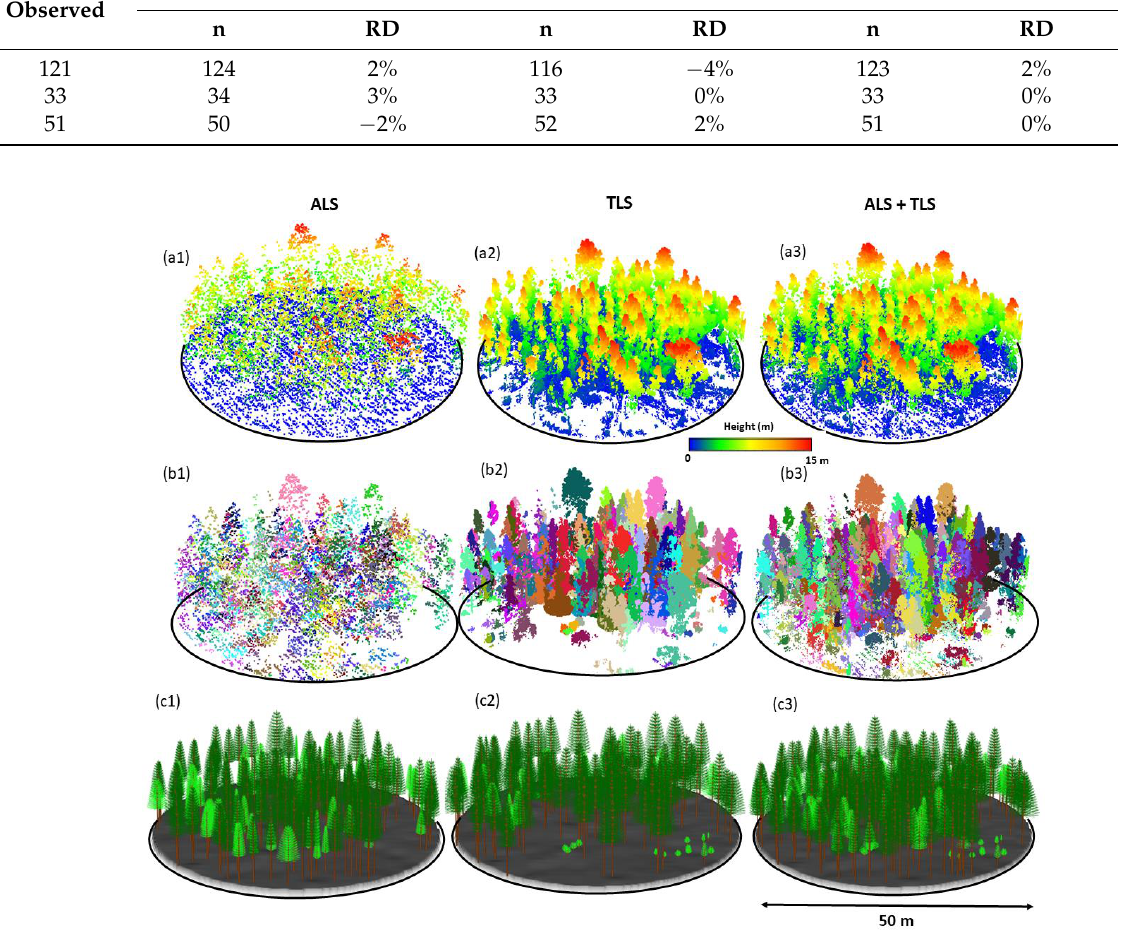
Figure 3. Illustration of the individual tree detection (ITD) and extraction from ALS, TLS, and ALS + TLS data in one of the plots: ( a1 – a3 ) raw point cloud of ALS, TLS, and ALS + TLS data colored by point height above ground; ( b1 – b3 ) point cloud trees of ALS, TLS, and ALS + TLS segmented by the ITD algorithm; ( c1 – c3 ) 3D representation of the trees in the plots retrieved from ALS, TLS, ans ALS + TLS data